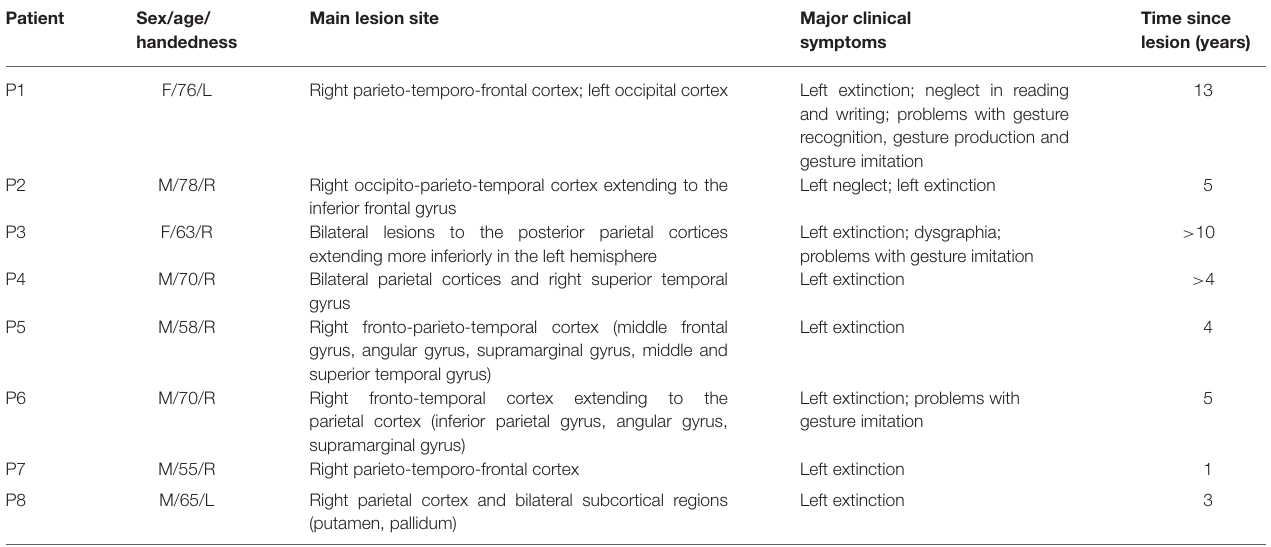
TABLE 1 | Demographic and clinical data of the